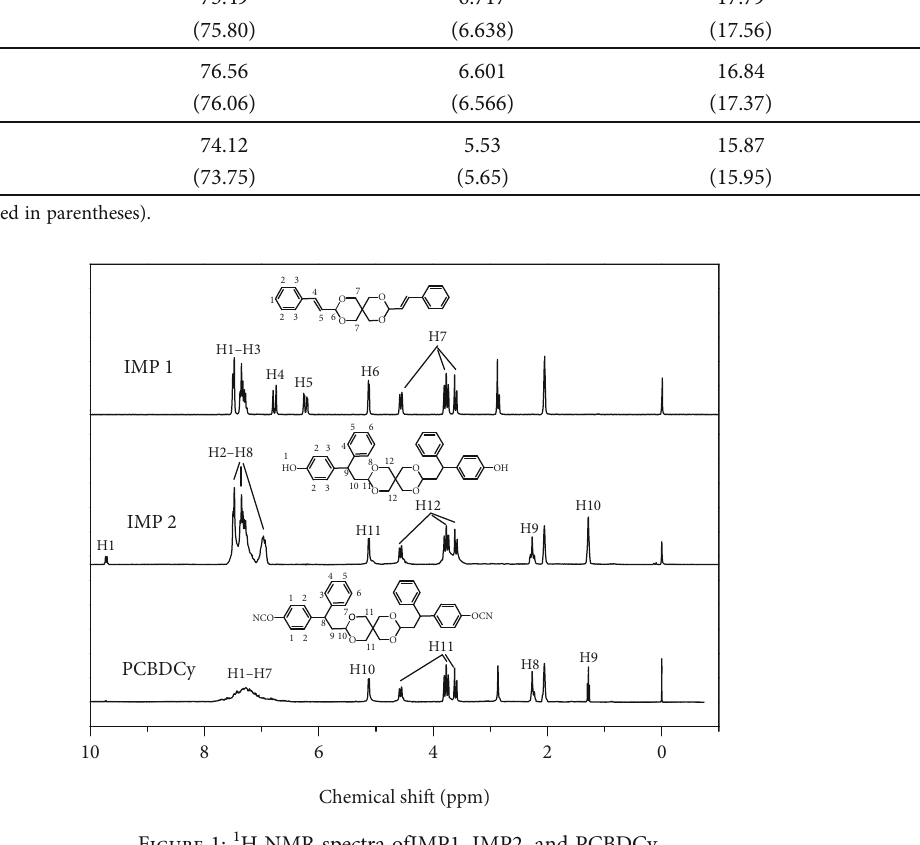
Figure 1: 1 H NMR spectra ofIMP1, IMP2, and